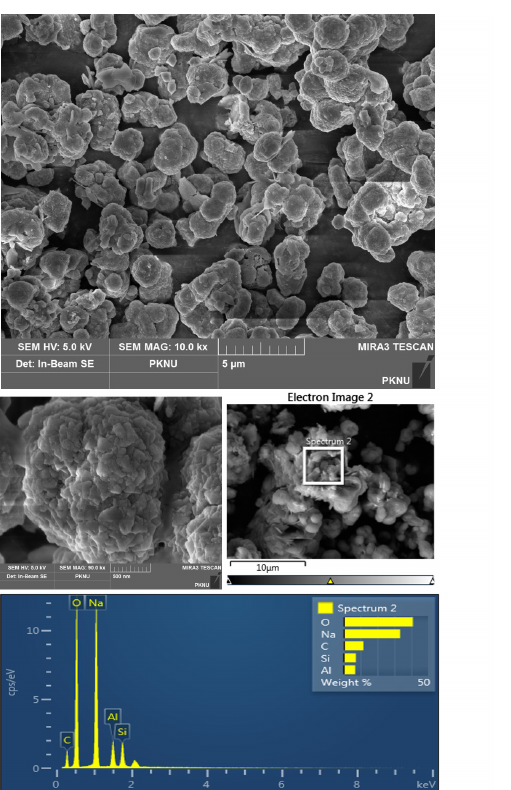
Figure 4. SEM image of zeolite.